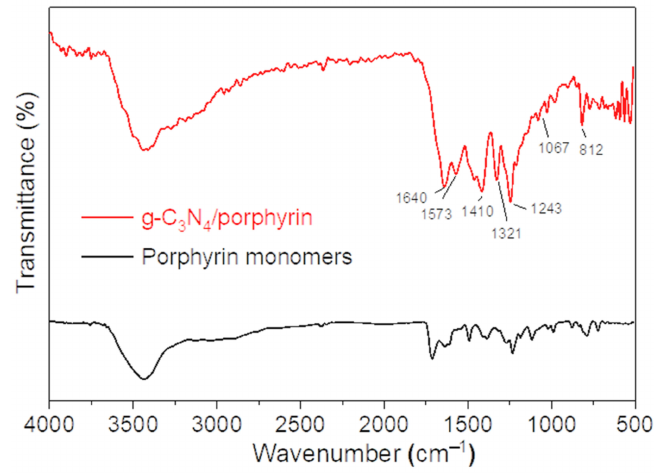
Figure 3. FTIR spectrum of TCPP porphyrin monomer and g-C 3 N 4 /porphyrin hybrid material.